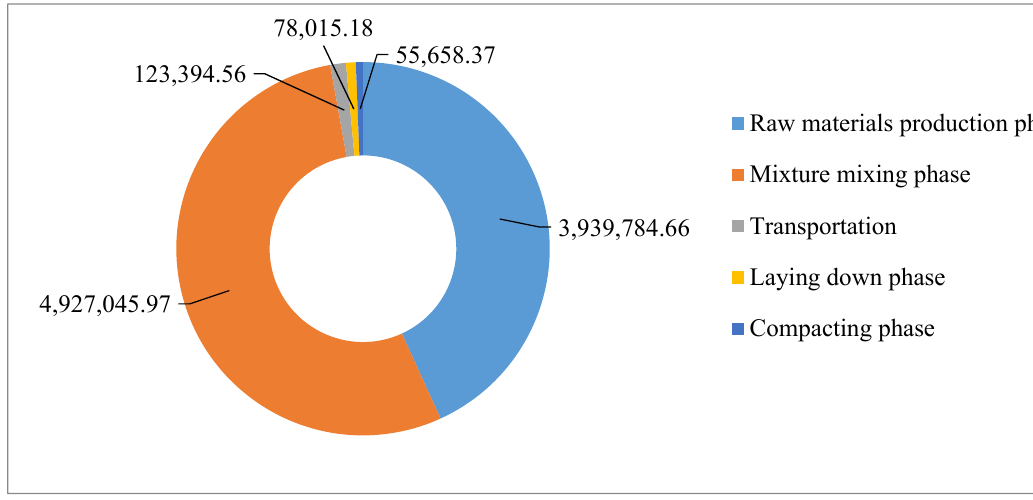
Figure 6. CO2e emission of asphalt course construction (unit: kg).